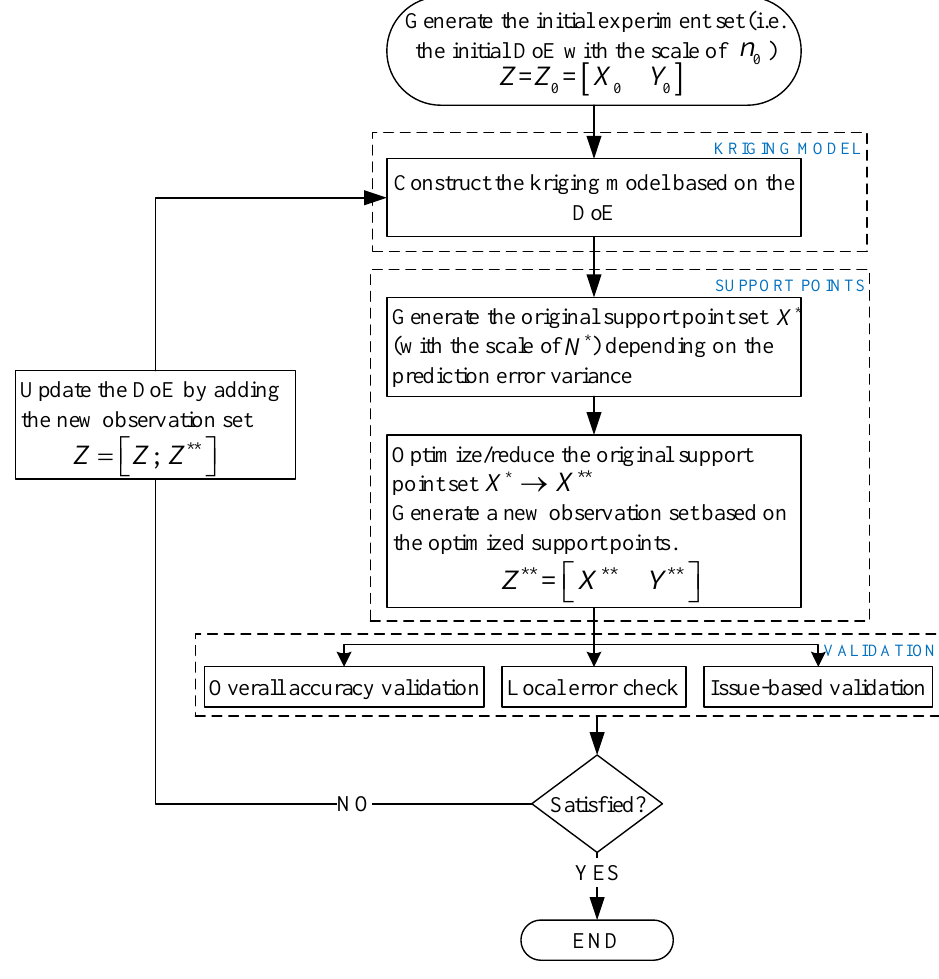
Figure 5. Kriging-based adaptive surrogate modeling framework.